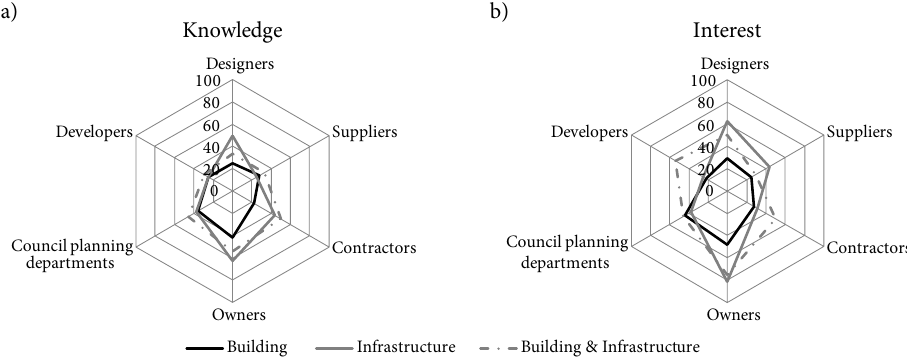
Fig. 1. levels of: a) knowledge and b) interest of stakeholders, as perceived by construction